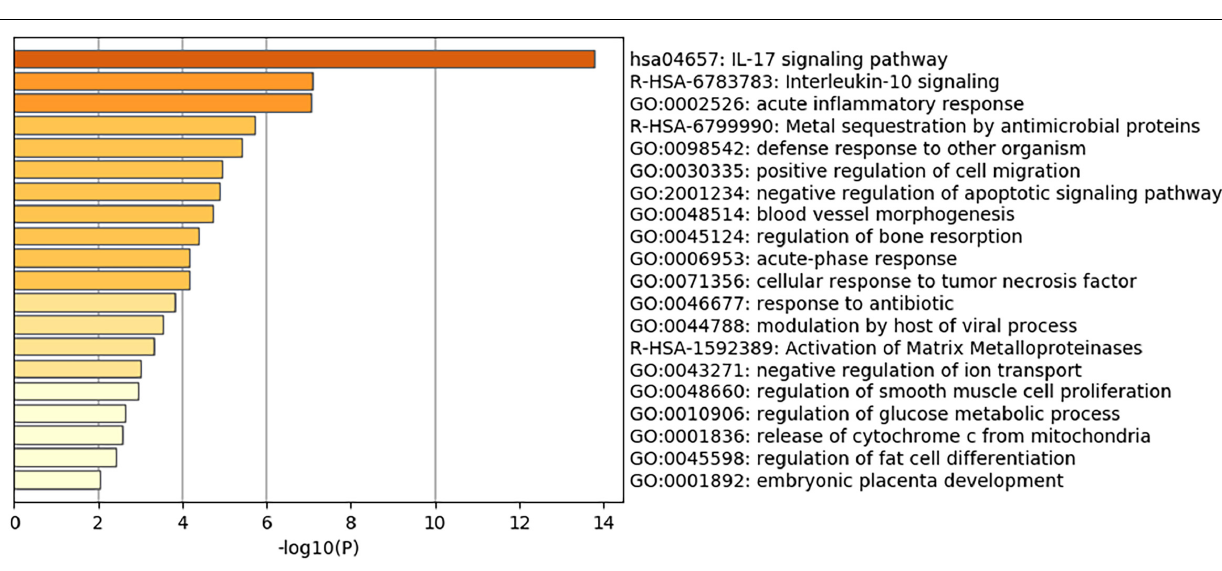
Frontiers in Physiology | www.frontiersin.org